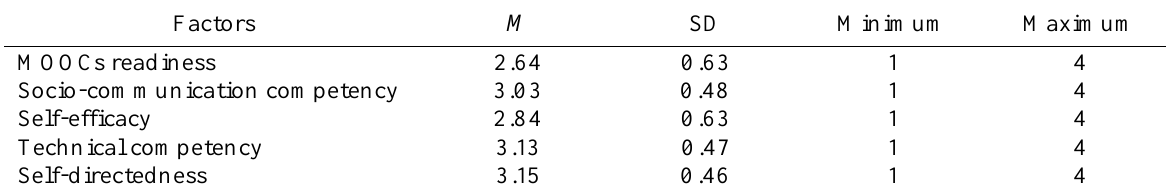
Means and Standard Deviations of the Four Factors Influencing MOOCs Readiness